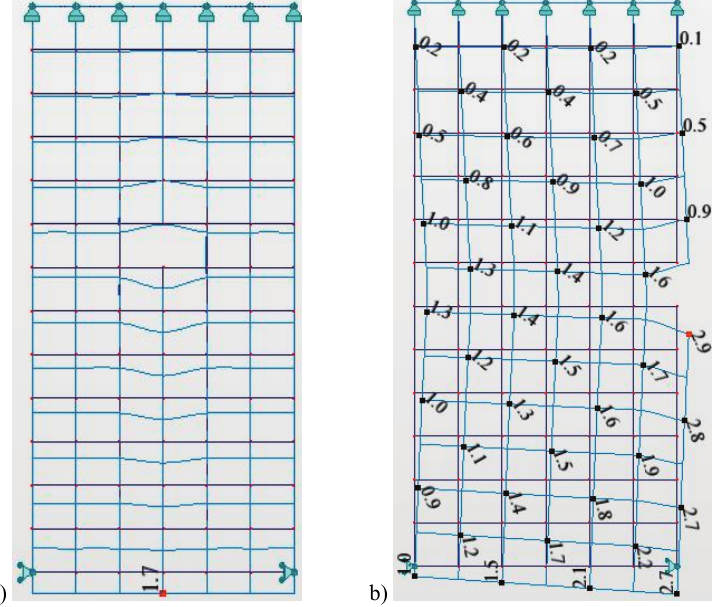
Fig. 5. Displacement of the load evenly distributed in: a) welded mesh, b) woven mesh